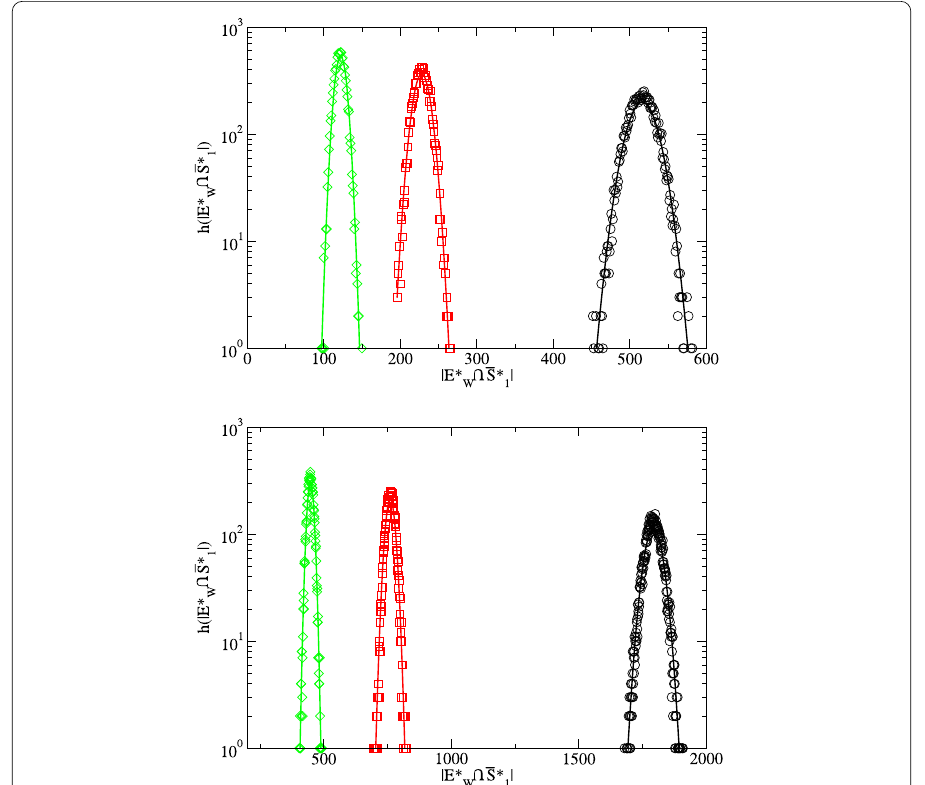
Figure 11 Histograms h ( | E ∗ W ∩ ¯ S ∗ 1 | ) from simulations (symbols) and their least square fits (lines) with W = 1 (black ◦ ), 2 (red (cid:3) ), 3 (green ♦ ) for years t = 1992 (top) and t = 2000 (bottom). All histograms have been constructed from M = 10 4 Monte Carlo